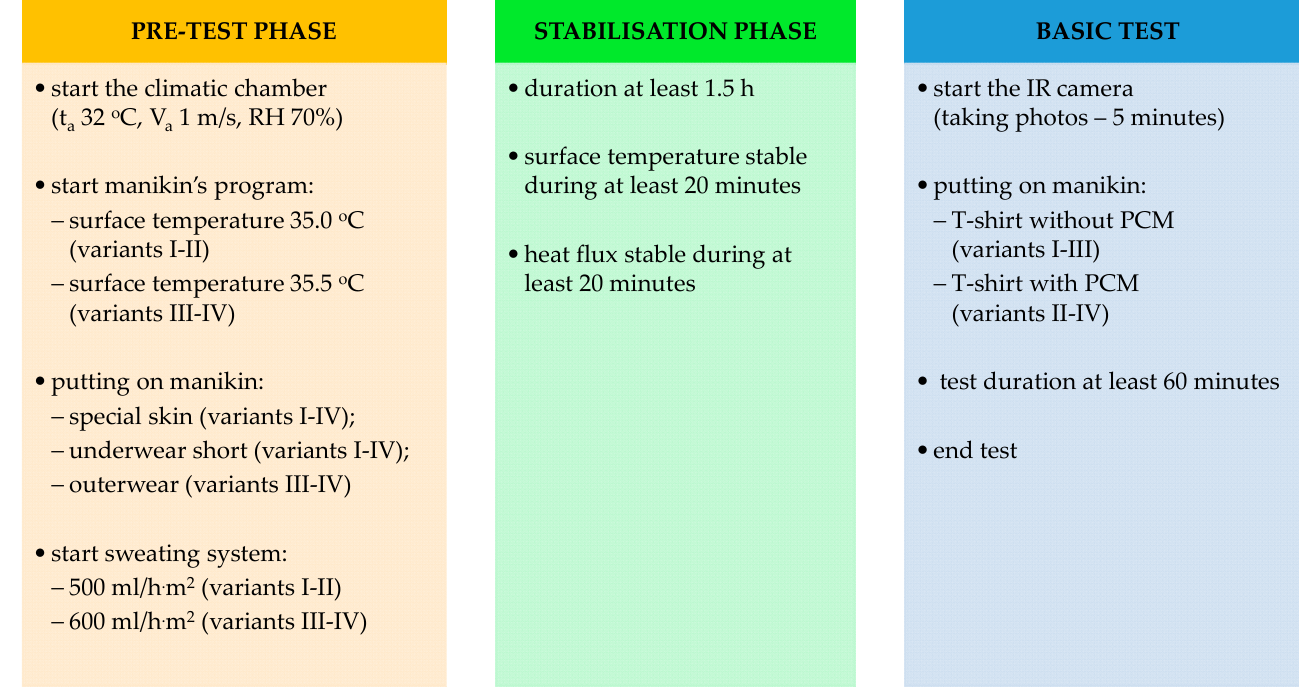
Figure 3. Test scheme.